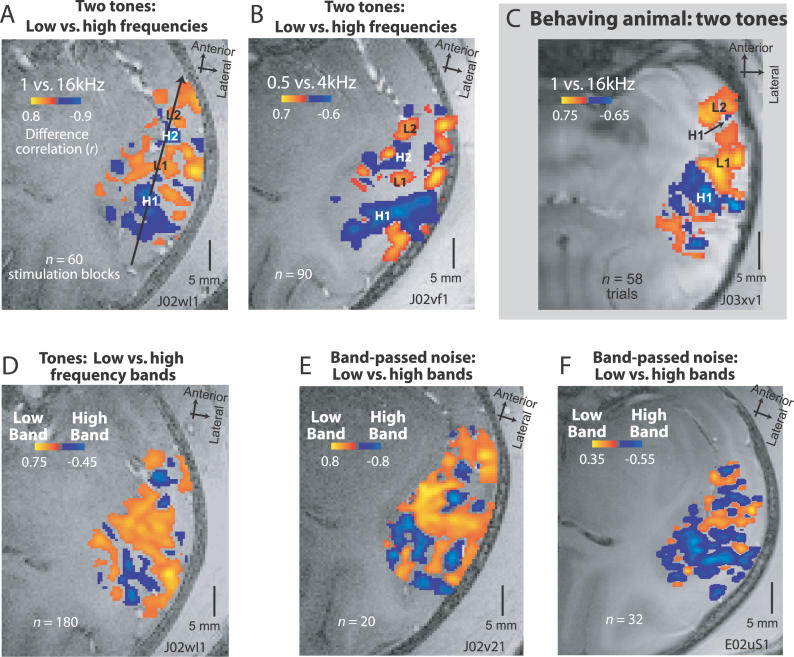
Reliable Frequency-Selective Regions in the Behaving and in the Anesthetized AnimalsObserved throughout these examples are the two pairs of high and low frequency selective regions as shown in
Figure 3, i.e., H1, L1, H2, and L2. (A–C) the results from using two tones. (A–B) show different scanning days with the same anesthetized animal as in
Figure 5 (J02, the animal and the experiment are identified in the lower right of each panel). Arrow in (A) shows the axis along which the frequency selective regions lie. (C) Behaving animal results (animal J03). (D–F) Further results with anesthetized animals (J02 and E02). (D) Results using two combinations of tone frequencies (Low: 0.5, 1, and 2 kH tones; High: 4, 8, and 16 kHz tones). (E–F) In two animals these panels reveal the patterns of activity for low and high frequency one-octave band-passed noise (Low: 0.5–1 kHz; High: 4–8 kHz).